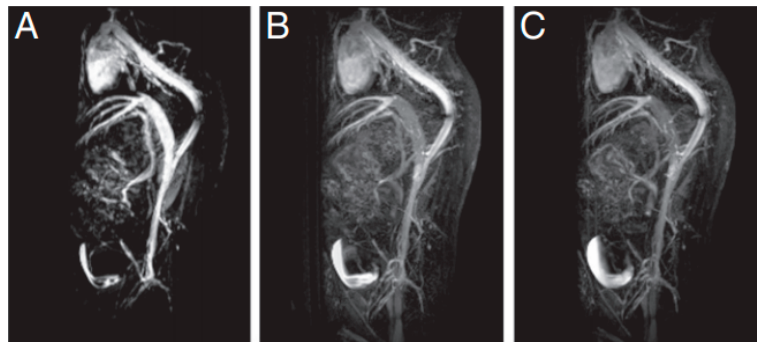
Figure 11. T 1 -weighted MR angiography, at 7 T, of a mouse ( A ) 4 min; ( B ) 12 min; and ( C ) 20 min, after the injection of ZES-SPIONs. Reprinted from H. Wei, O. T. Bruns, M. G. Kaul, E. C. Hansen, M.